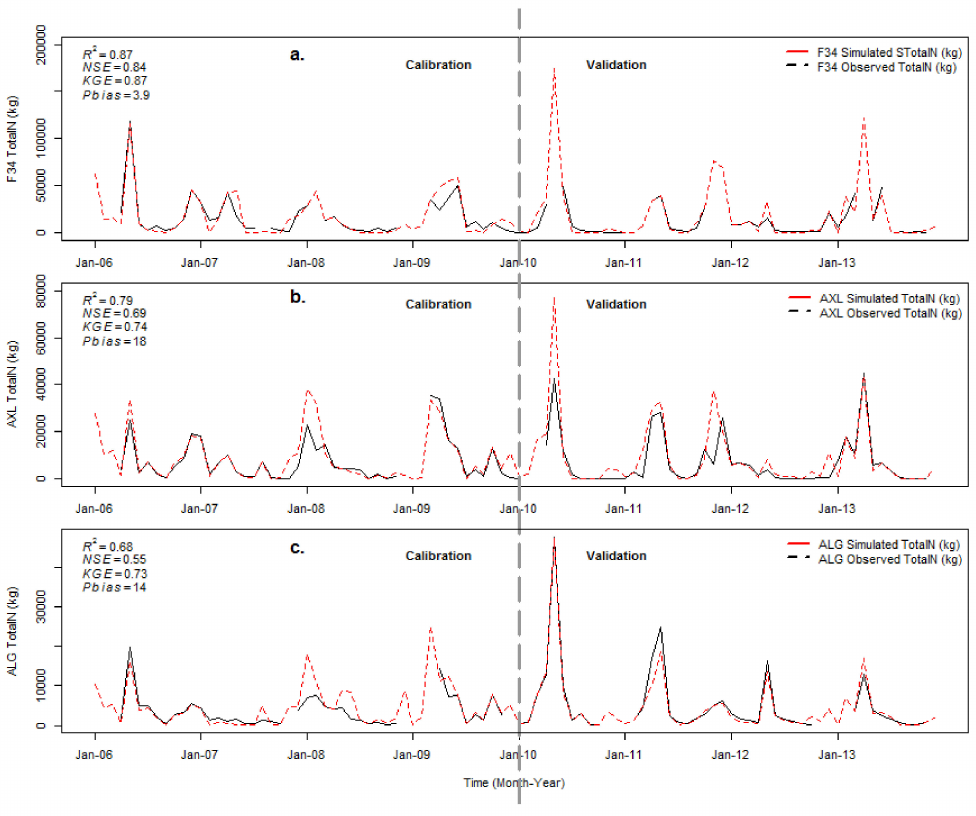
Figure A2. Monthly time series of simulated and observed total N for ( a ) F34, ( b ) AXL, and ( c ) ALG. There were no measured total N data available for CCW to perform calibration and validation.